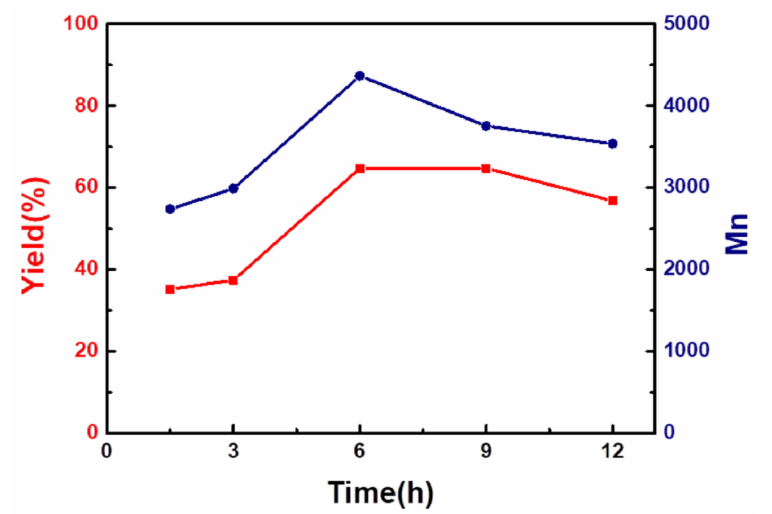
Figure 2. Yield (left) and number average molecular weight (right) vs. time graph of Eug-HDI